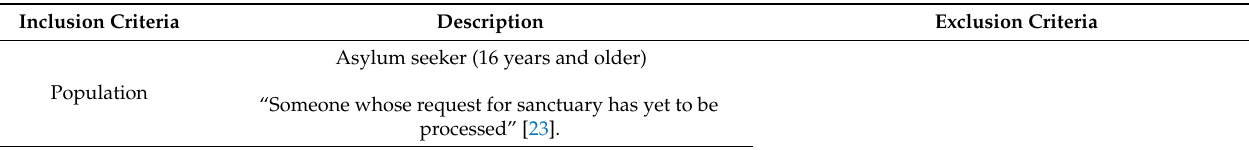
Table 1. Selection Criteria for studies included in the